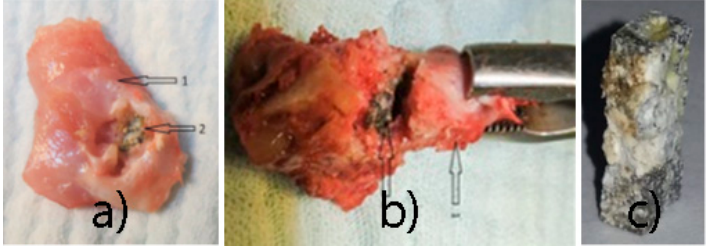
Figure 14. Post-extraction images: ( a ) muscular block (1), alloy sample (2); ( b ) bone block (1), alloy sample (2), ( c ) alloy sample after extraction.